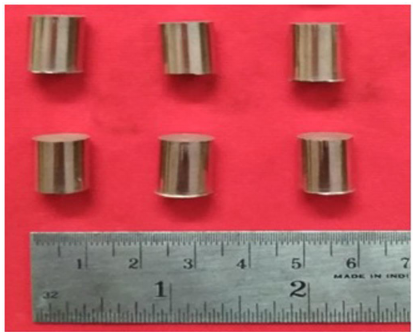
Figure 1: WC/Cu partial and fully sintered electrode Table 1: Process parameters and their range in the study